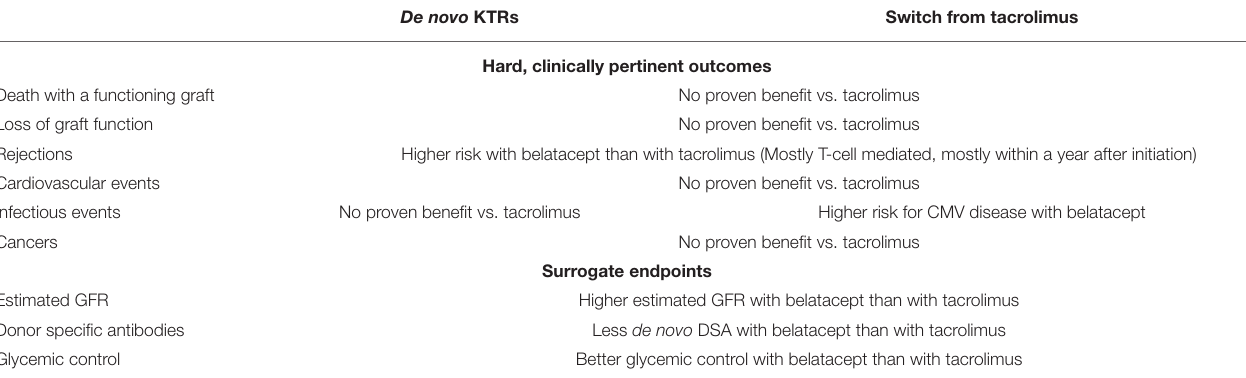
TABLE 2 | Current evidence, based on data from comparative studies, on the benefits to use belatacept instead of tacrolimus for kidney transplant